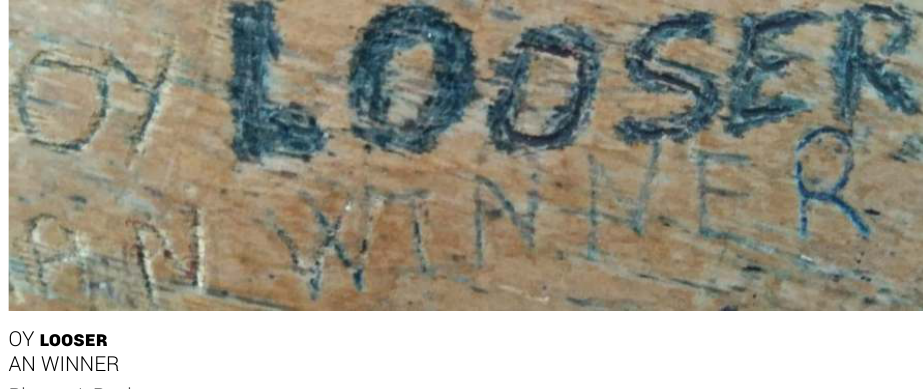
Table 3 d: Gaming reference found on desktops at the University of Bordeaux